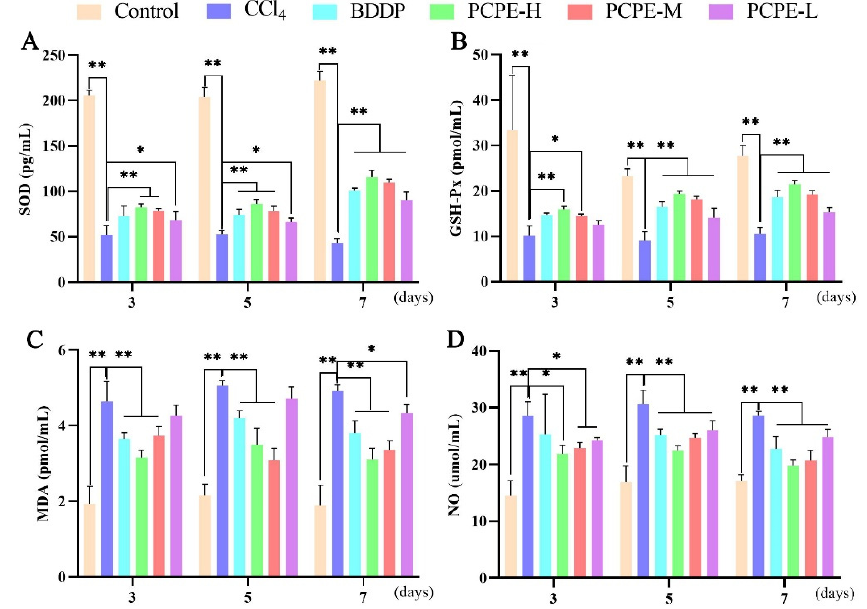
Figure 4. PCPE effects on serum antioxidant indices. ( A ) SOD, ( B ) GSH-Px, ( C ) MDA, ( D ) NO. Data represented as Means ± SD. * and ** indicates p < 0.05, p < 0.01, respectively.